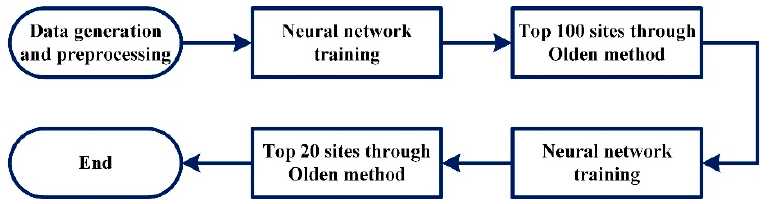
Figure 2. Sensitivity analysis procedure based on neural network.